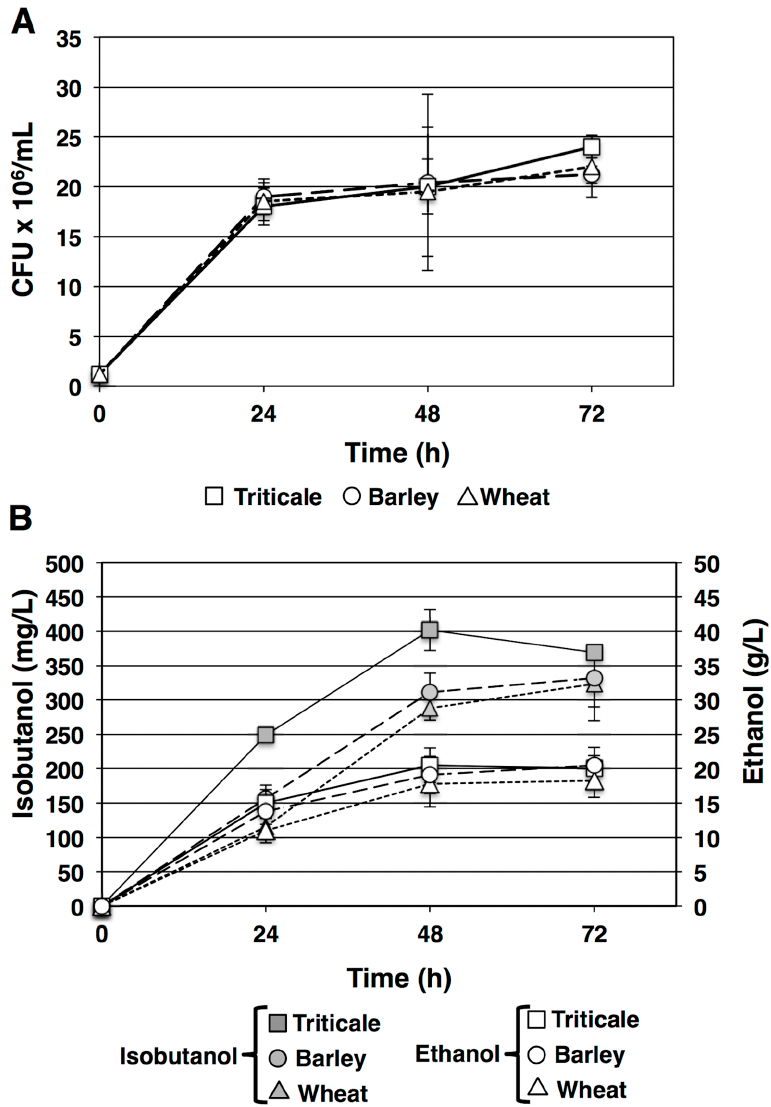
Figure 1. SSF of triticale (squares), wheat (triangles) and barley (circles) mashes. ( A ). Viable yeast cells in each mash at each time point determined by CFU. Data shown are mean values from triplicate platings. Error bars indicate standard deviation. ( B ) Isobutanol concentration in mg/L (filled symbols) and ethanol concentration in g/L (open symbols) was measured in the triticale (squares), wheat (triangles) and barley (circles) cultures. Values displayed are the means of triplicate measures. Error bars indicate standard deviations.